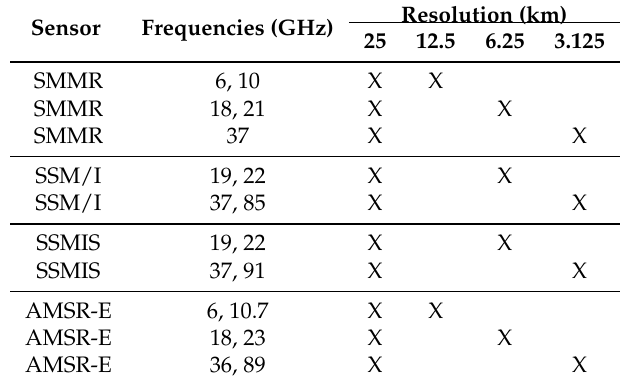
Table 2. CETB ESDR gridded spatial resolutions, by sensor and measurement frequency. All data are produced as twice-daily EASE-Grid 2.0 images, as smoothed (25 km) grids, and at enhanced spatial resolutions as indicated here. Further details are available in the User Guide, available at http://nsidc.org/data/nsidc-0630. Sensor Frequencies